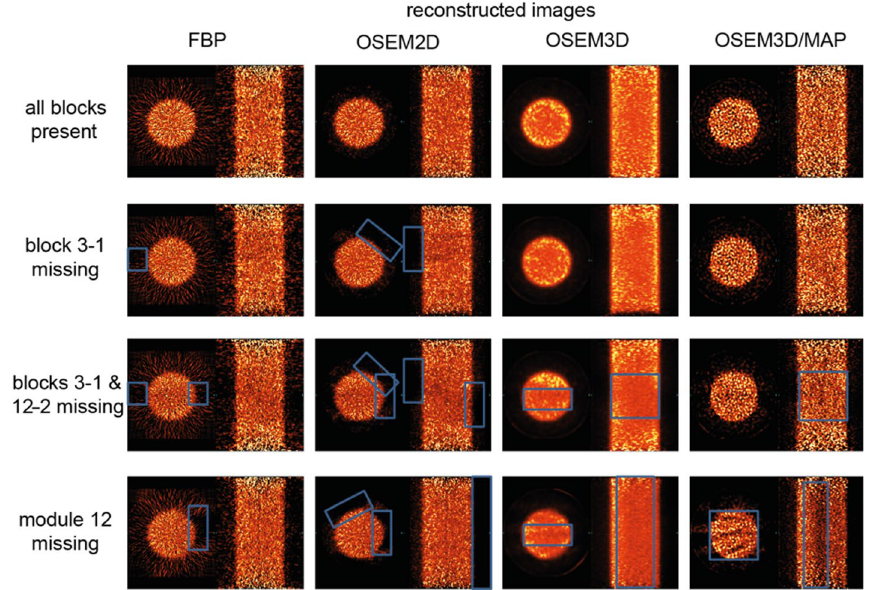
Fig. 4 Reconstructed images of a homogeneous phantom reconstructed with 2D filtered backprojection (FBP), ordered subset expectation maximization (OSEM) in 2D and 3D and a combination of OSEM3D with maximum a posteriori